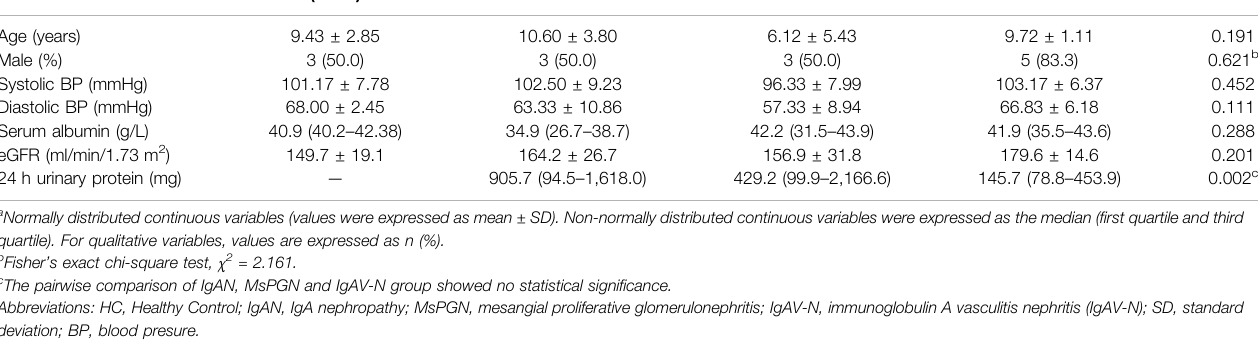
Table S4 ). Then we selected miR-98-5p and miR-152-3p for further validation.